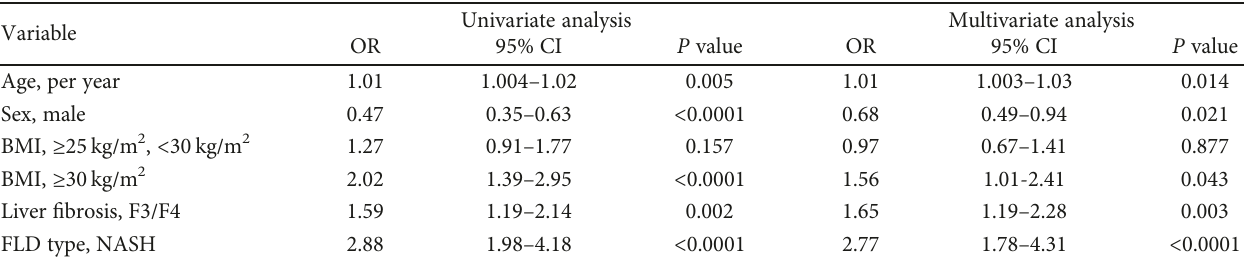
Table 3: Associations of ASH and NASH with DM.